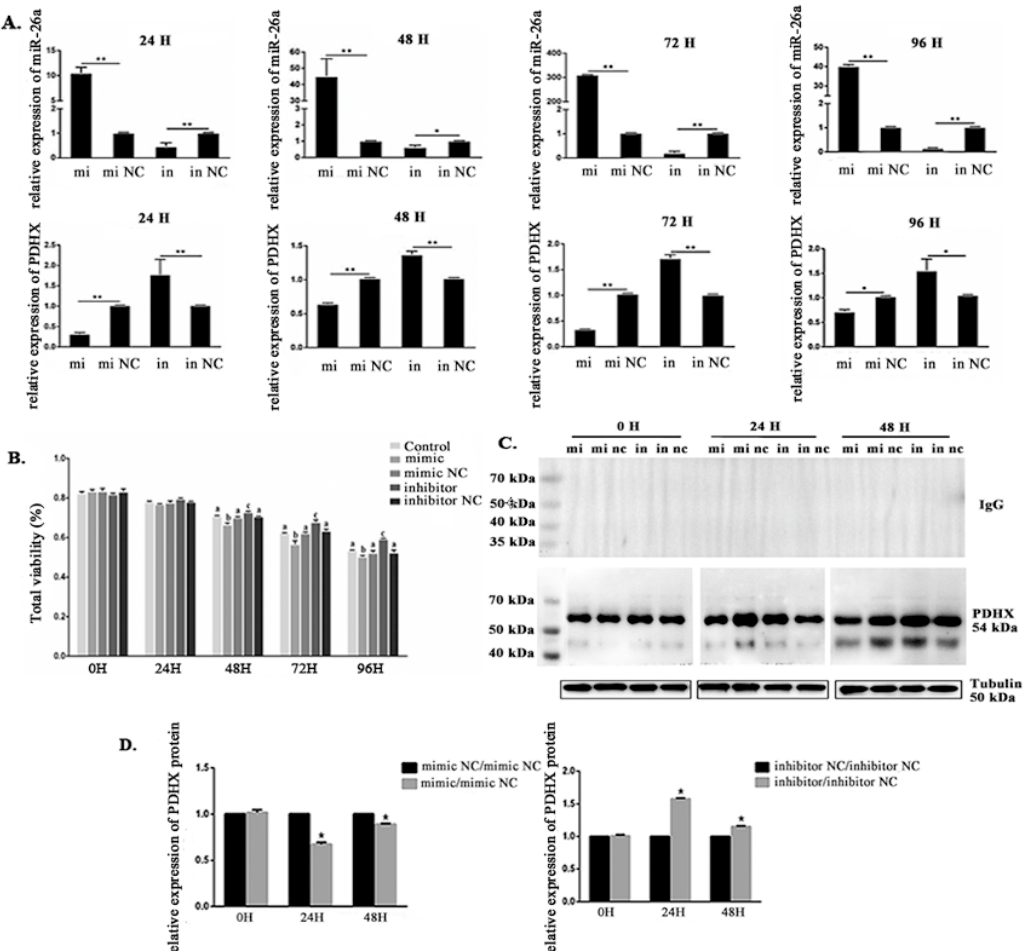
Figure 5. The expression level of miR-26a and PDHX , and sperm viability in miR-26a transfected boar sperm at 17 ◦ C. ( A ) Sperm viability after miR-26a transfection. ( B ) The expression level of miR-26a and PDHX after transfection with miR-26a mimic, mimic control, miR-26a inhibitor and inhibitor control for 24 h, 48 h, 72 h and 96 h, respectively. ( C ) WB analysis after 0 h, 24 h, and 48 h treatment with miR-26a mimic/mimic NC and inhibitor/inhibitor NC showing the expression of PDHX and β -tubulin. The negative control rabbit IgG in place of the primary antibody was used. ( D ) The relative protein level of PDHX after transfection with miR-26a mimic and inhibitor. Values were normalized using β -tubulin protein as an internal reference, and then mimic NC and inhibitor NC groups were used as references to measure the relative expression levels. mi: mimic; mi nc: mimic NC; in: inhibitor; in nc: inhibitor NC. “*” indicates statistical significance at P < 0.05 and “**” indicates statistical significance at P < 0.01. Different alphabets indicate statistical significance at P < 0.05.